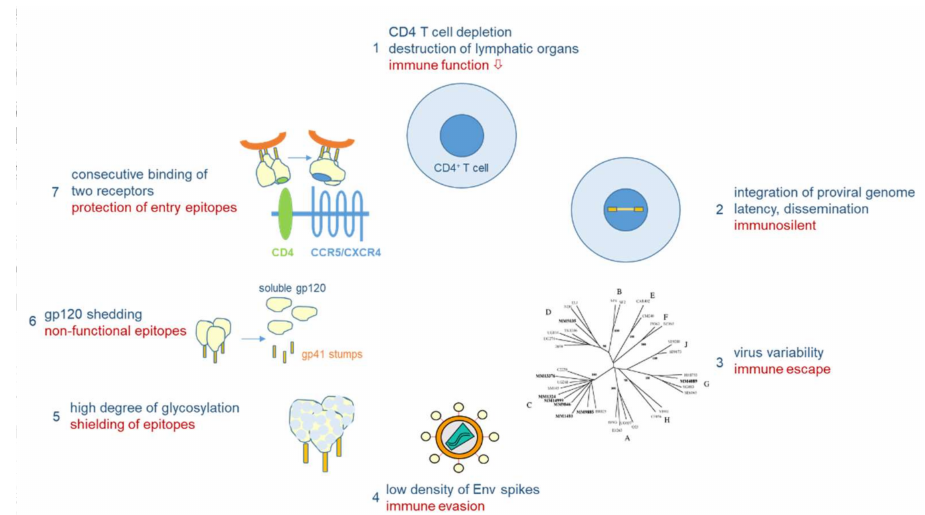
Figure 4. Immune evasion mechanisms of HIV-1. HIV-1 infects CD4 + cells, major players in adaptive immunity (1). Proviral integration results in lifelong persistence (2). Virus variability leads to immunological escape (3). Antigenicity is lowered by low number of HIV-1 envelope (Env) spikes (4) and extensive glycosylation (5). Non-functional Env epitopes are exposed through shedding of gp120 (6). Functional entry epitopes are protected through consecutive receptor interactions linked to conformational changes in Env